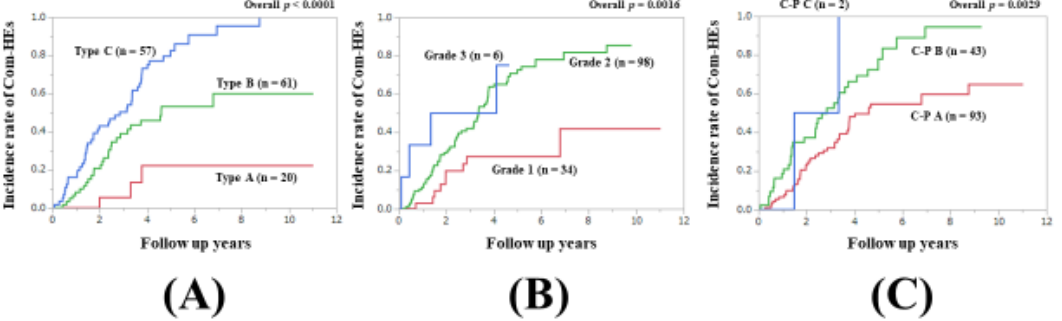
Figure 4. Cumulative incidence rates of composite hepatic events in patients with FIB4 index >4.46 (median value in our cohort, n = 138). ( A ) Serum Zn level grading system. ( B ) ALBI grading system. ( C ) Child–Pugh classification.